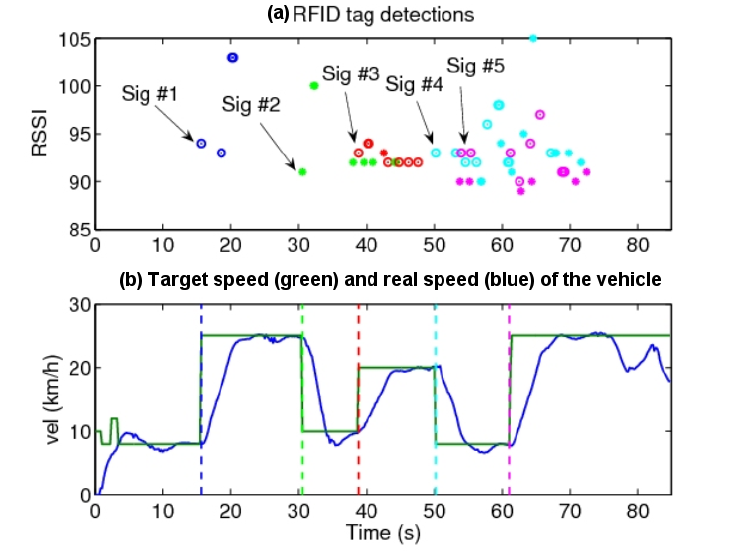
Figure 10. (a) Detection of the RFID tags of the traffic signals of Figure 6; (b) change of the target speed (green) and real speed (blue) of the vehicle according to the RFID